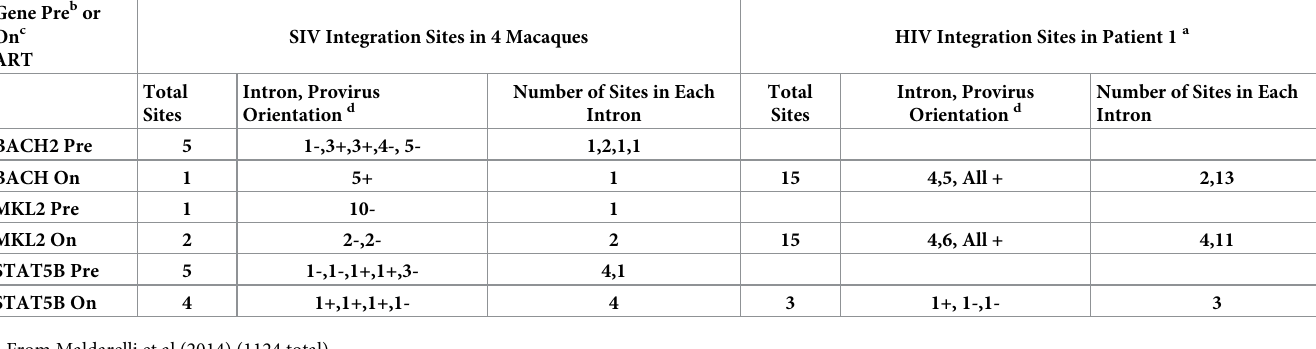
Table 11. SIV integration sites in genes where integration has been linked to clonal expansion in an HIV-infected patient.